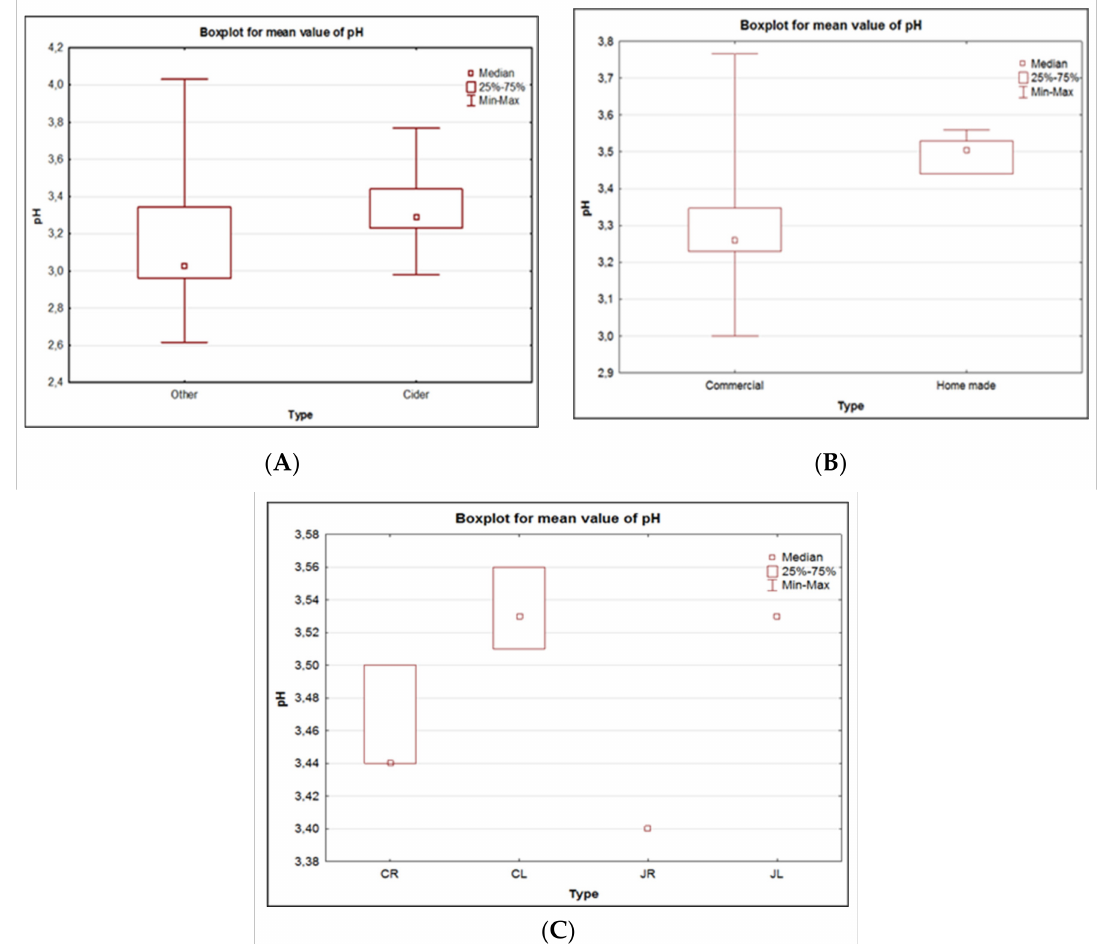
Figure 3. Boxplot of pH value divided according to type of alcohol (ciders–others ( A )), type of production of ciders (commercial–home-made ( B )) and type of juice used for home-made ciders production (CR-CL-JR-JL ( C